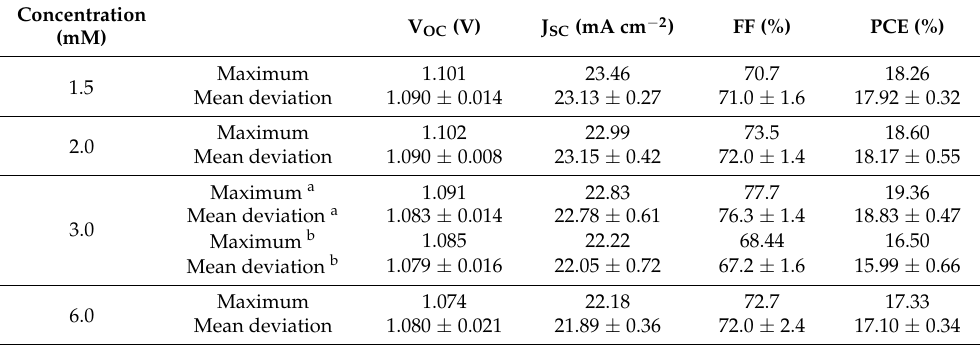
Table 3. The photovoltaic characteristics of PSCs with various concentrations of I 2